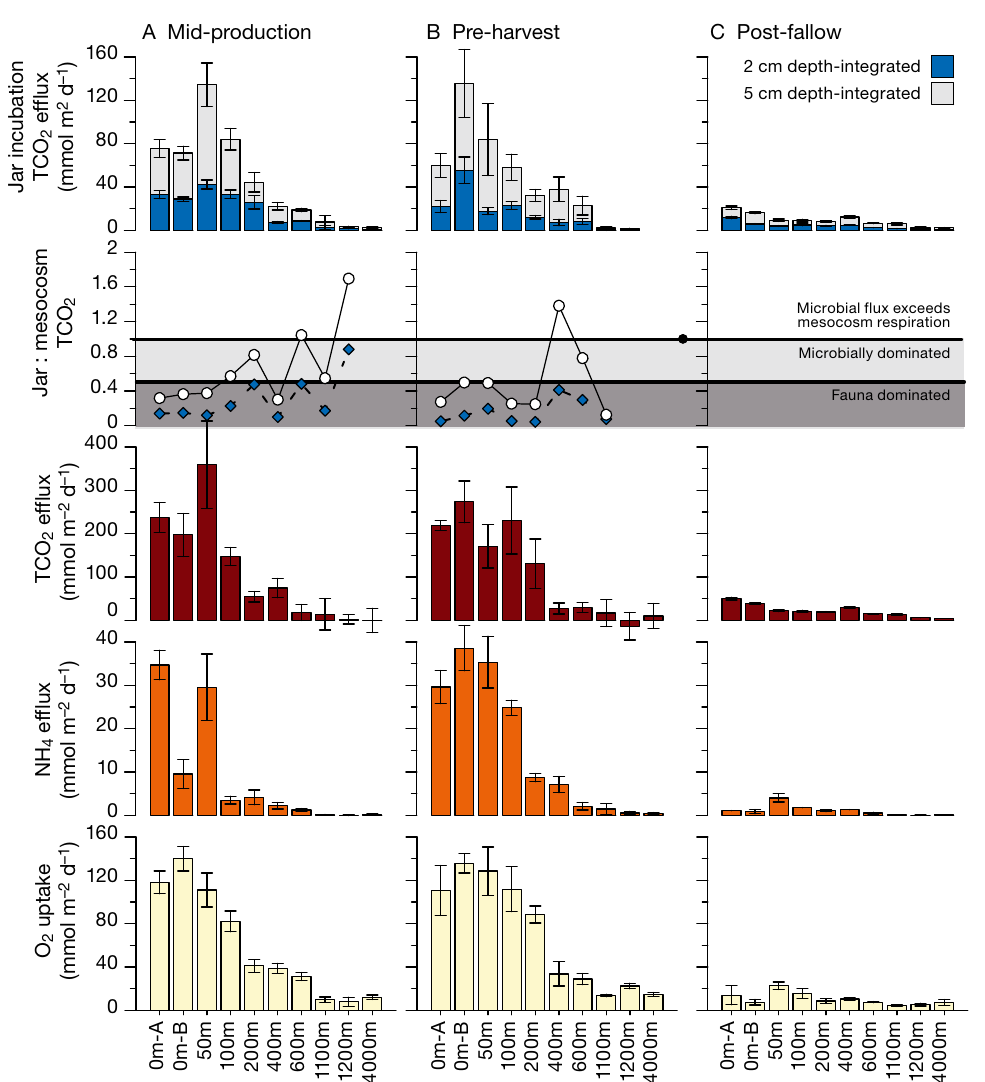
Fig. 7. Benthic respiration. Top row: average total carbon dioxide (TCO 2 ) efflux from top 2 cm of sediment and top 5 cm of sed- iment from jar incubations of decaudated sediments. Second row: ratio between TCO 2 efflux from jar incubations (microbial) and respiration cores (ignoring ratios that include near-0 or negative values). Bottom 3 rows: TCO 2 and NH 4 effluxes and O 2 uptake from natural respiration cores for each sampling station (labeled according to distance to nearest farm) during each of the last 3 surveys. Note: TCO 2 efflux for the post-fallow survey was estimated based on the TCO 2 production from the jar incu- bations (see Section 2). Error bars represent ±1